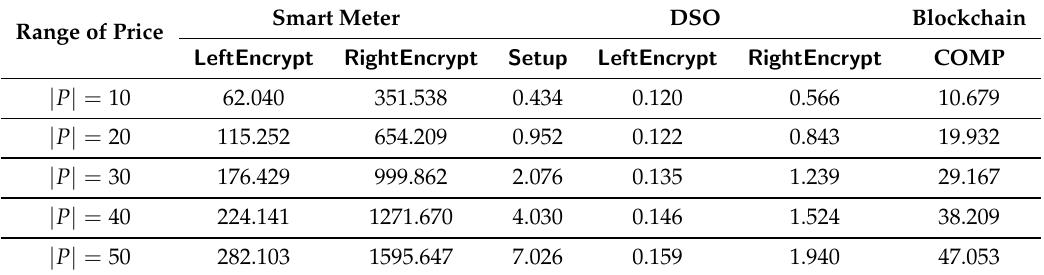
Table 1. MeasuredtimesforperformingFHIPEoperationsinsmartmeter, DSO,andblockchain(milliseconds). Smart Meter Range of Price